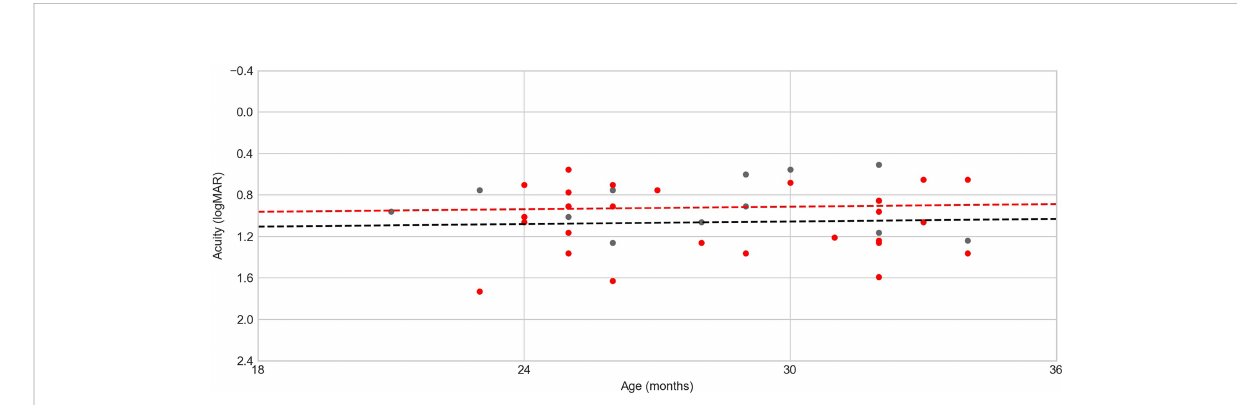
FIGURE 2 Age (in months) × visual acuity (VA). Red dots denote children with some kind of fundoscopic alteration, black dots indicate children without fundoscopic alterations, and dotted lines represent the age × acuity regression model for each group ( red line for the group of children with fundoscopic alterations and black line for the group of children without fundoscopic alterations). There is no tendency because of the homogeneity in the children ’ s ages.